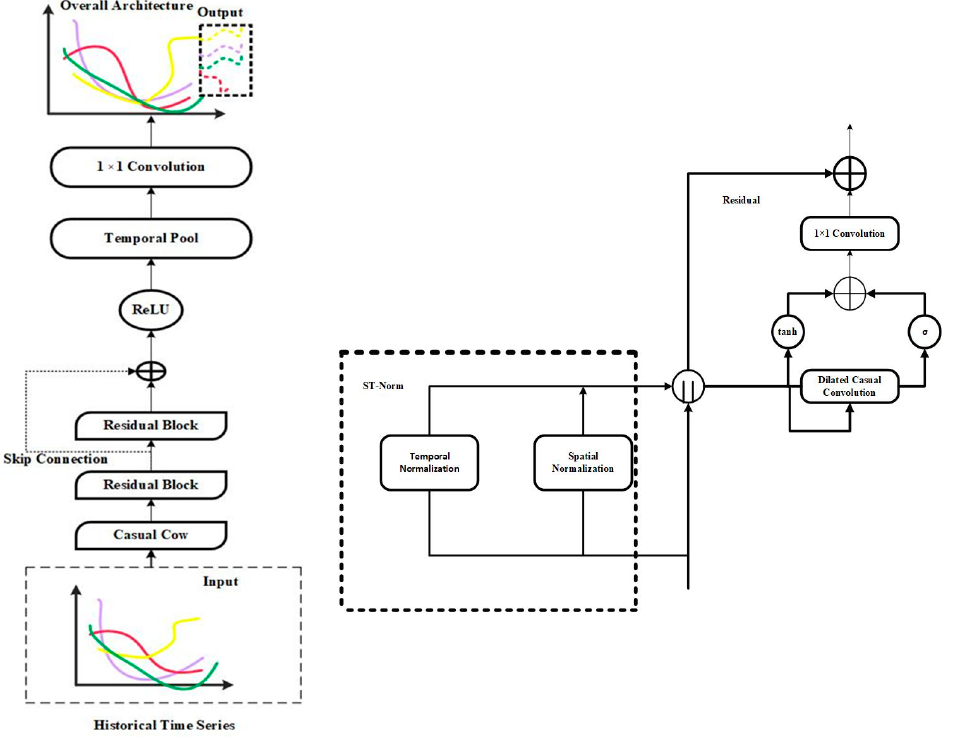
Figure 1. Overall high-level assessment structure.